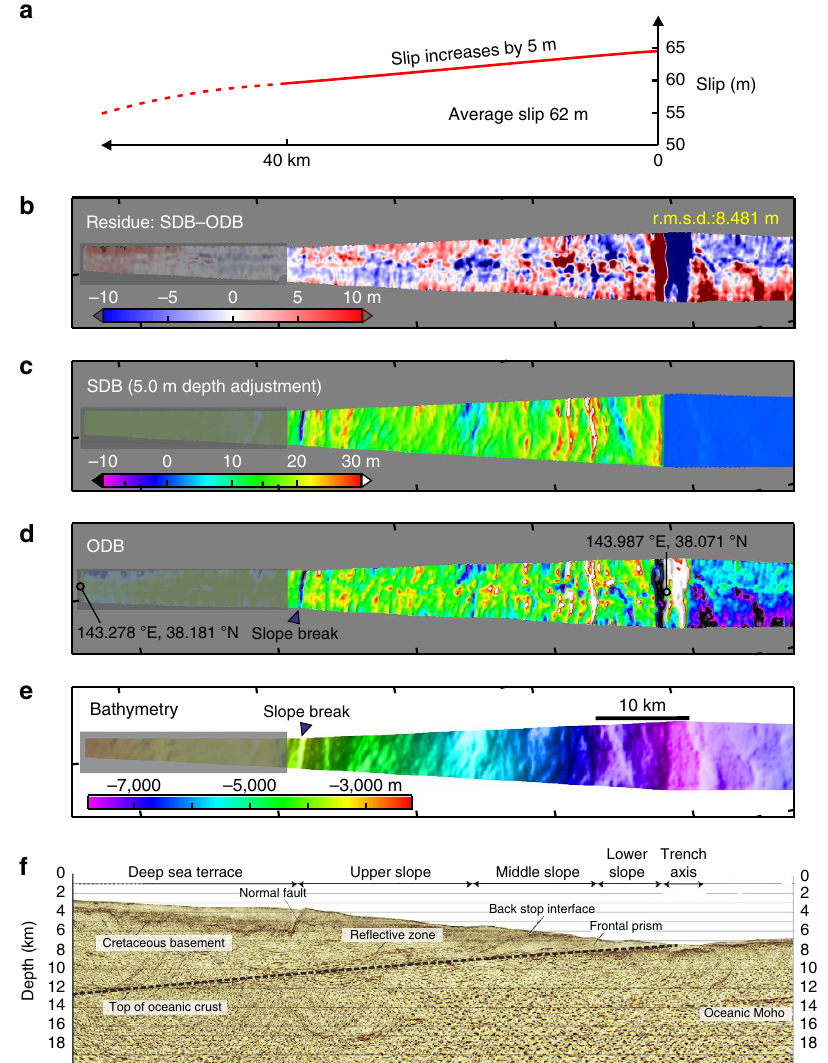
Figure 3 | The optimal SDB model along the central corridor. The location of the corridor is shown in Fig. 1 inset. ( a ) Fault slip distribution over the most seaward 40km. ( b ) Residue between the SDB ( c ) and 1999–2011 ODB ( d ). ( c ) SDB produced using the slip distribution shown in a . ( d ) 1999–2011 ODB. ( e ) Bathymetry acquired in 1999. The deep sea terrace segment ( o 3,500m; shadowed in b – e ) has large uncertainties in water sound speed and the interpreted seafloor depth. Possible submarine landslides at the trench axis are not modelled in the SDB. Therefore, these segments as well as that seaward of the trench are not included for calculating the r.m.s.d. ( f ) Seismic reflection section along the same track 2 . Thick dashed line shows the megathrust